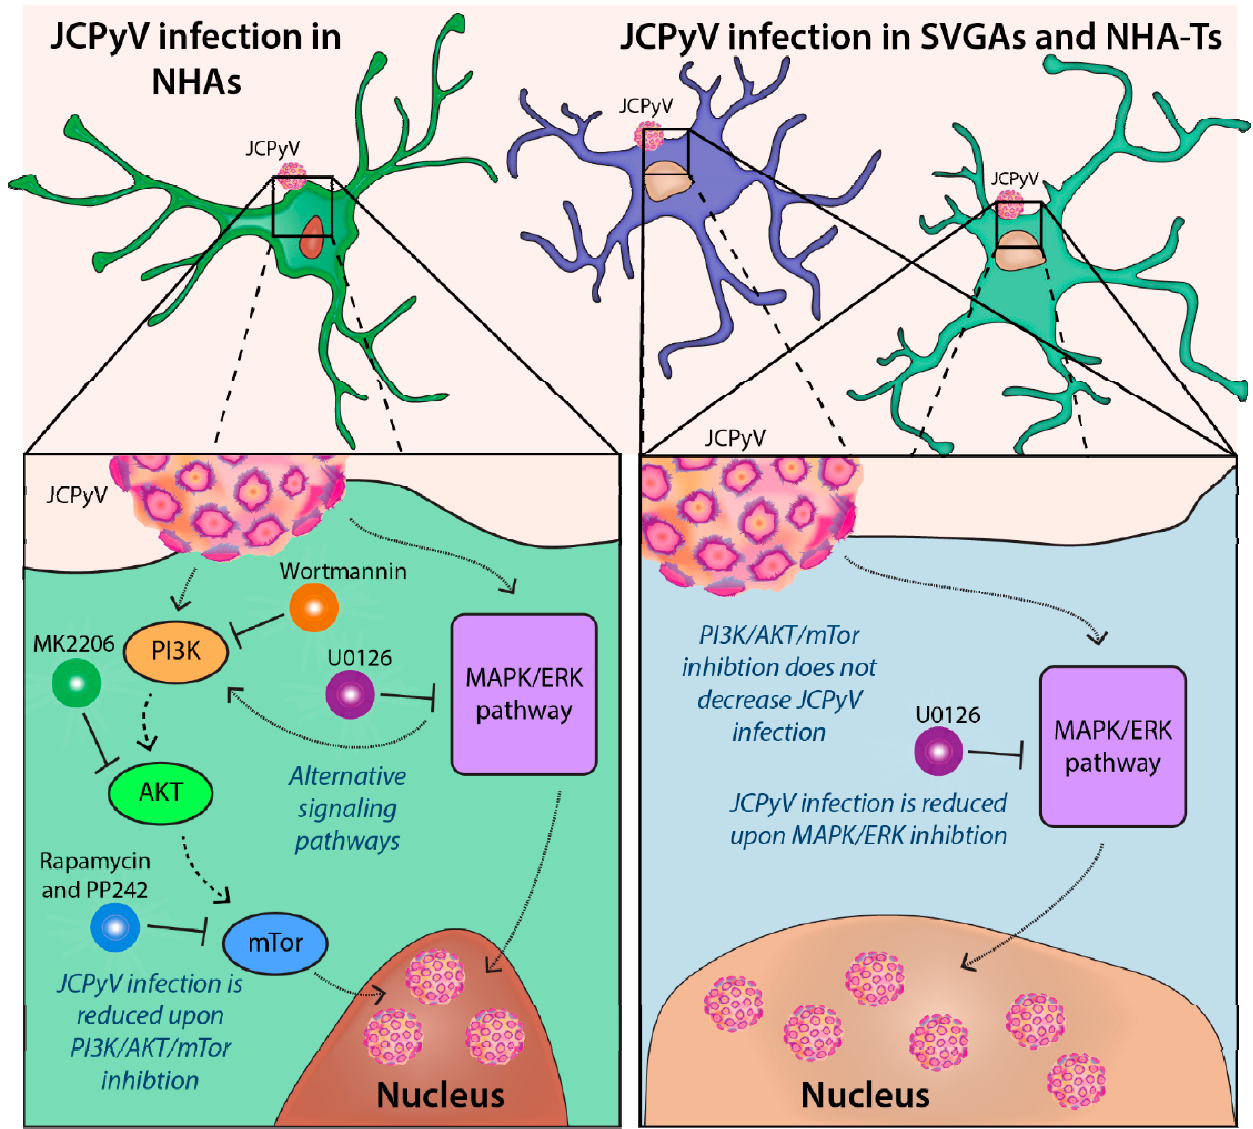
Figure 7. Chemical inhibitors that reduce JCPyV infection in NHAs, SVGAs, and NHA-Ts. Previous research has demonstrated the importance of the MAPK/ERK pathway in NHAs; however, JCPyV can also use the PI3K/AKT/mTOR signaling pathway for infection ( left ). Using chemical inhibitors targeting PI3K, AKT, and mTOR significantly reduced JCPyV infection in primary astrocytes ( left ). However, in immortalized cells, SVGAs and NHA-Ts, these chemical inhibitors did not reduce JCPyV infection and treatment of cells with U0126—an MEK inhibitor of the MAPK/ERK pathway—which significantly reduced JCPyV infection ( right ). This demonstrates that during the viral infection of immortalized cells, JCPyV is more dependent on the MAPK/ERK pathway and may not use other pathways, such as the PI3K/AKT/mTOR signaling pathway, to establish successful infection, compared to JCPyV infection in primary astrocytes.